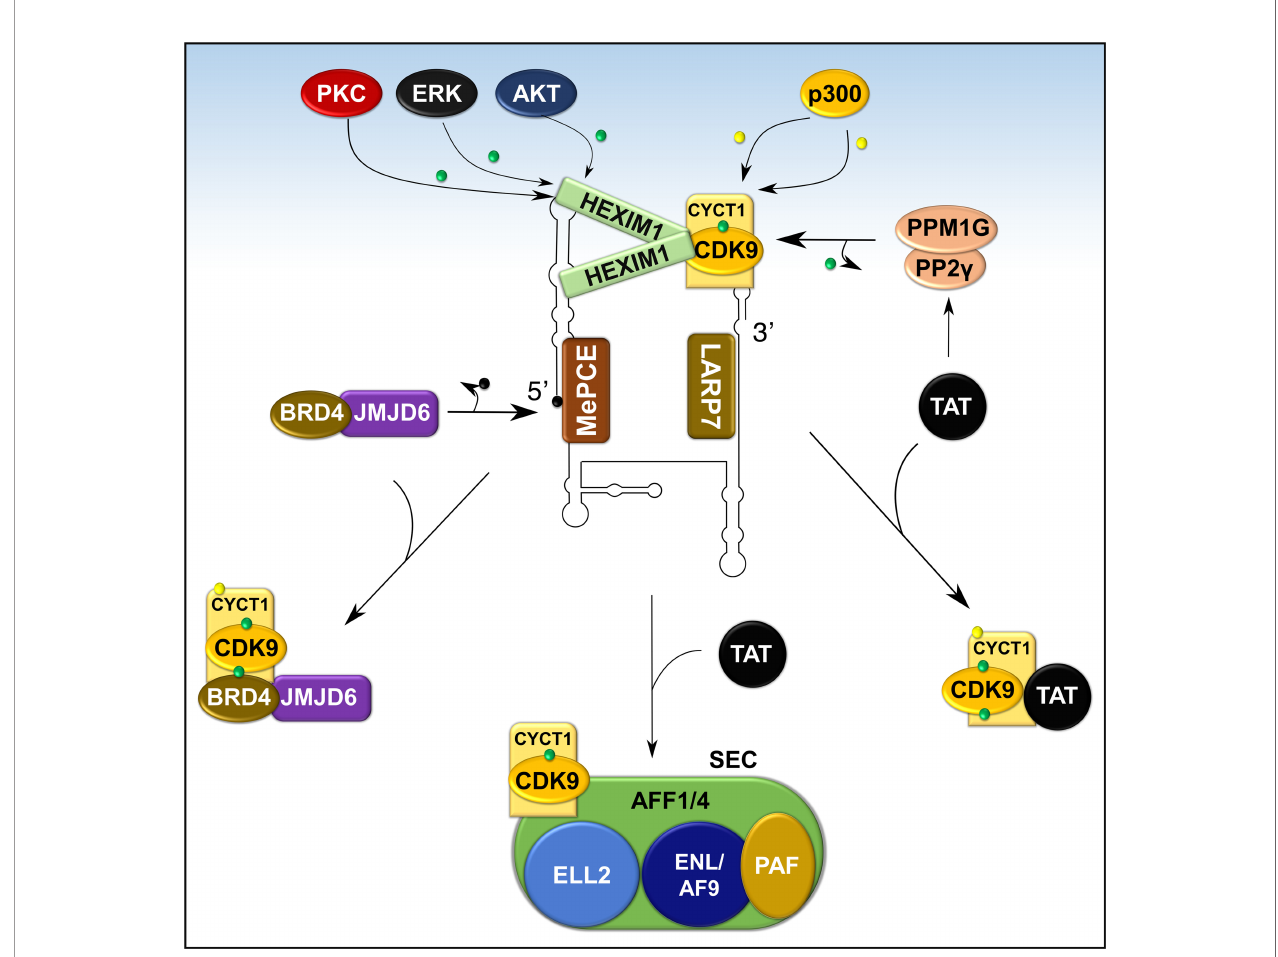
FIGURE 8 | Recruitment of P-TEFb from 7SK snRNP. Various signaling pathways and stress conditions liberate P-TEFb from 7SK snRNP through PTMs of the components of 7SK snRNP (HEXIM1 and cyclin T1) or direct recruitment (BRD4, TAT, or super elongation complex, SEC). The major PTM involves phosphorylation (green dot) of HEXIM1 in various residues and acetylation (yellow dot) of cyclin T1. TAT recruits P-TEFb by collaborating with phosphatases (PPM1G and PP2 g ) which dephosphorylate CDK9 on Thr186. Meanwhile, BRD4 interacts with JMJD6, a histone demethylase, which demethylates (black dot) the 5 ’ end of 7SK RNA and destabilizes the inhibitory core. AFF1/4, ALL-fused gene from chromosome 1/4 family member; ELL2, Eleven-nineteen lysine-rich in leukemia; ENL, Eleven nineteen leukemia; AF9, ALL-fused gene from chromosome